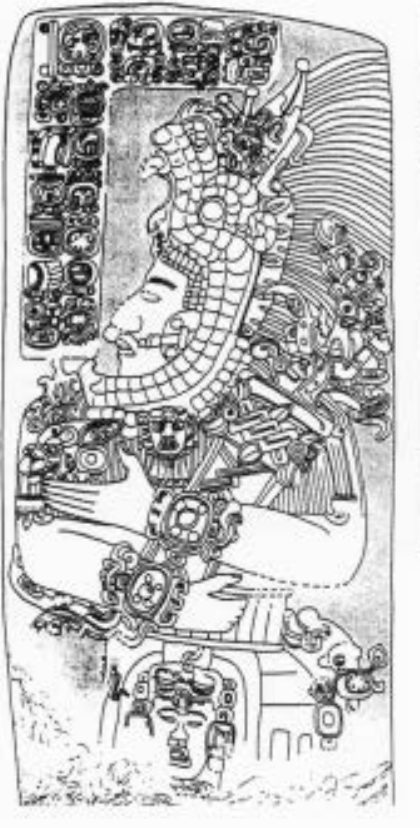
Figure 2 Stone stela 9 found at Lamanai.